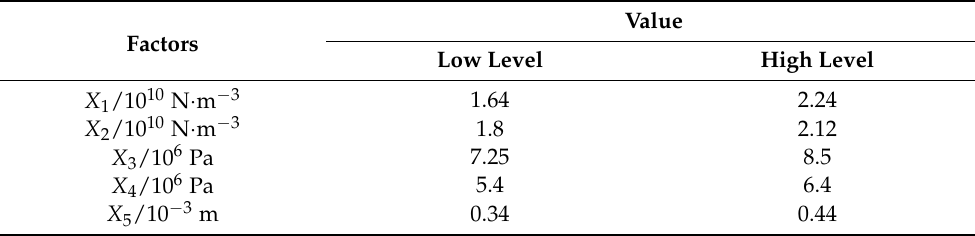
Table 3. Plackett–Burman test factors and